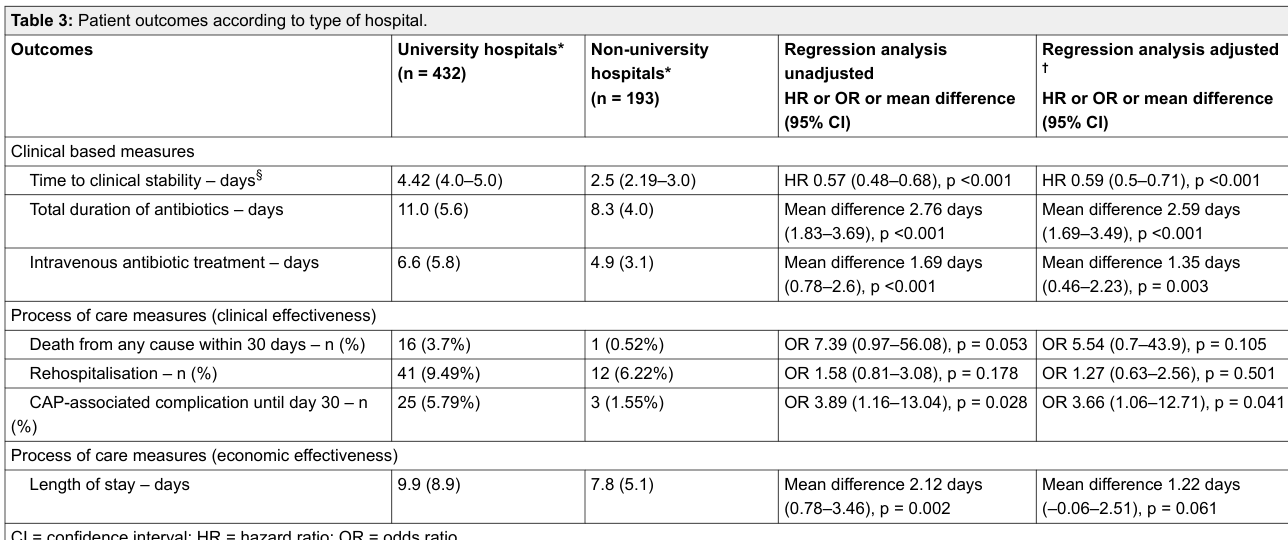
Table 3: Patient outcomes according to type of hospital.